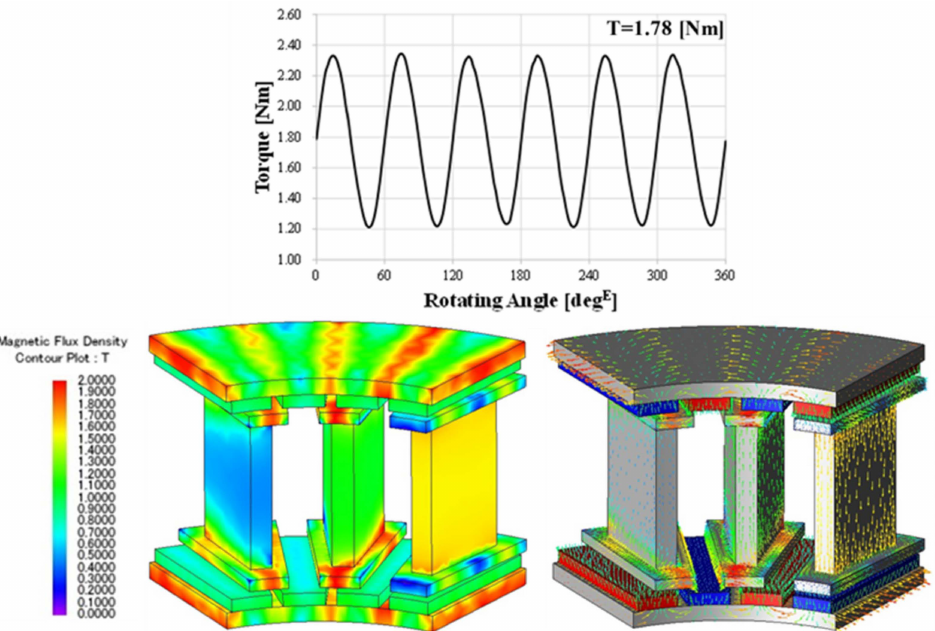
Figure 22. Torque waveform of the final DRAFPM motor and magnetic flux density distribution at